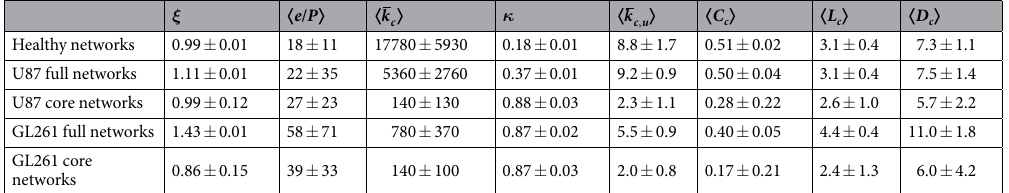
Table 4. Connectivity between communities. Isolation scaling exponents ξ from robust fits assuming ∼ ξ P e e ( ) , mean number of internal vessel segments per intercommunity edge e / P , mean community degree = + k e P 2 and assortativity exponent κ from fits approximating the neighboring degree relationship with 〈 〉 ∼ κ k k k ( ) mean number of unique topological neighbor-communities k characteristic path length L c and diameter D c of the meta-networks, averaged from all specimens, and given with